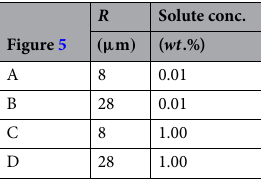
Table 1. Droplet radius ( R ) and bulk solute concentration (wt.%) in the aqueous phase for the monodisperse oil-in-water emulsions.